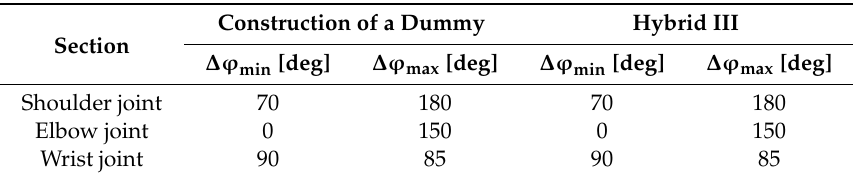
Table 2. Maximum value of the rotation joint of the anthropometric dummy and the Hybrid III dummy representing the 50th percentile male.